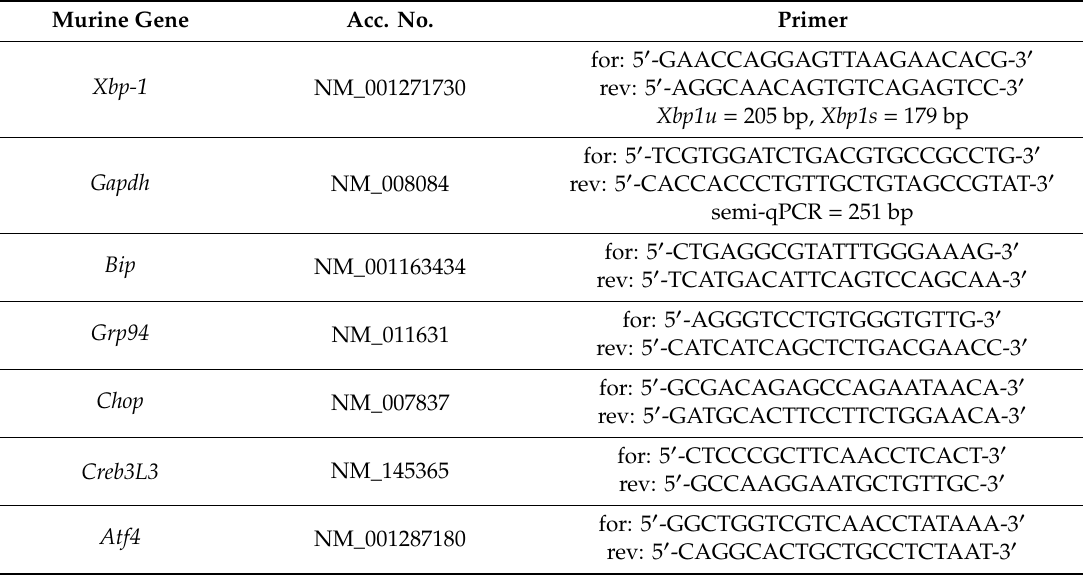
Table 1. Primers used in this study.